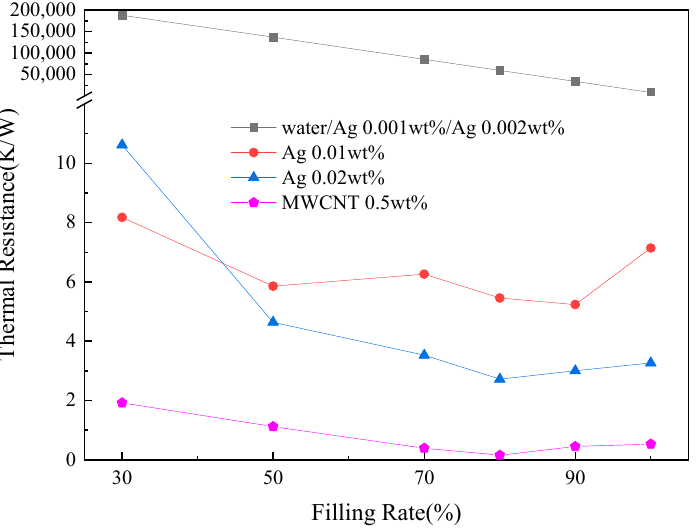
Figure 7. Variation of the thermal resistance with the filling ratio for PHP filled with different nanofluids.